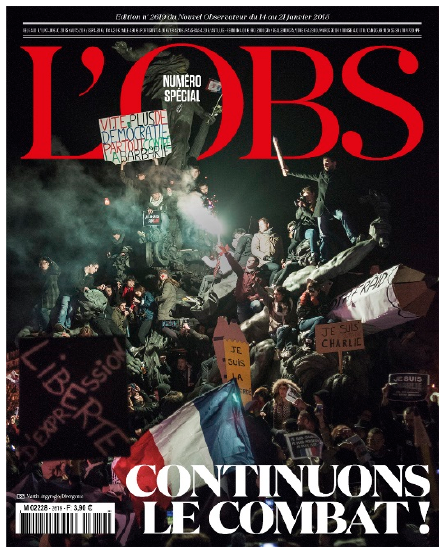
Figure 1. “Marianne Crayon”.